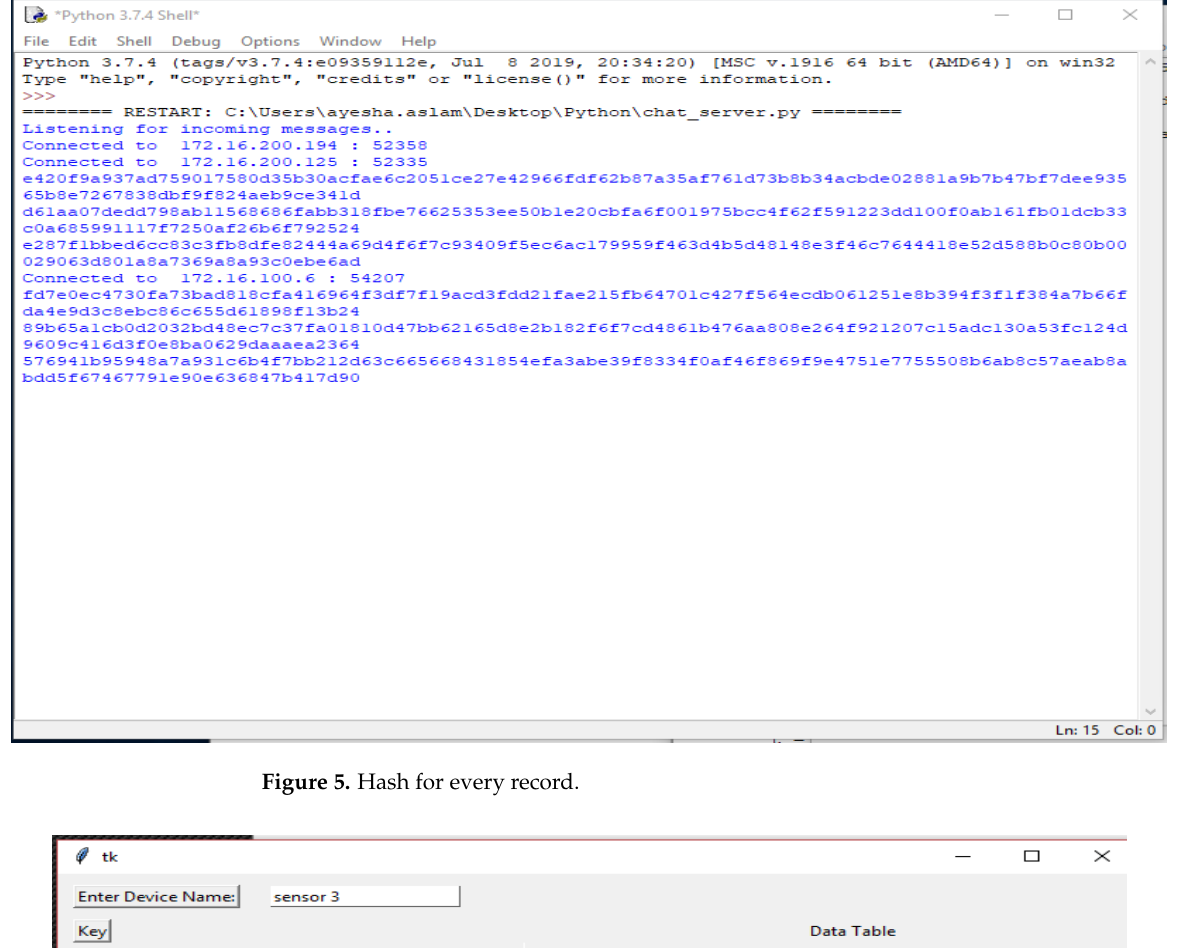
Figure 4. Data of the chain.